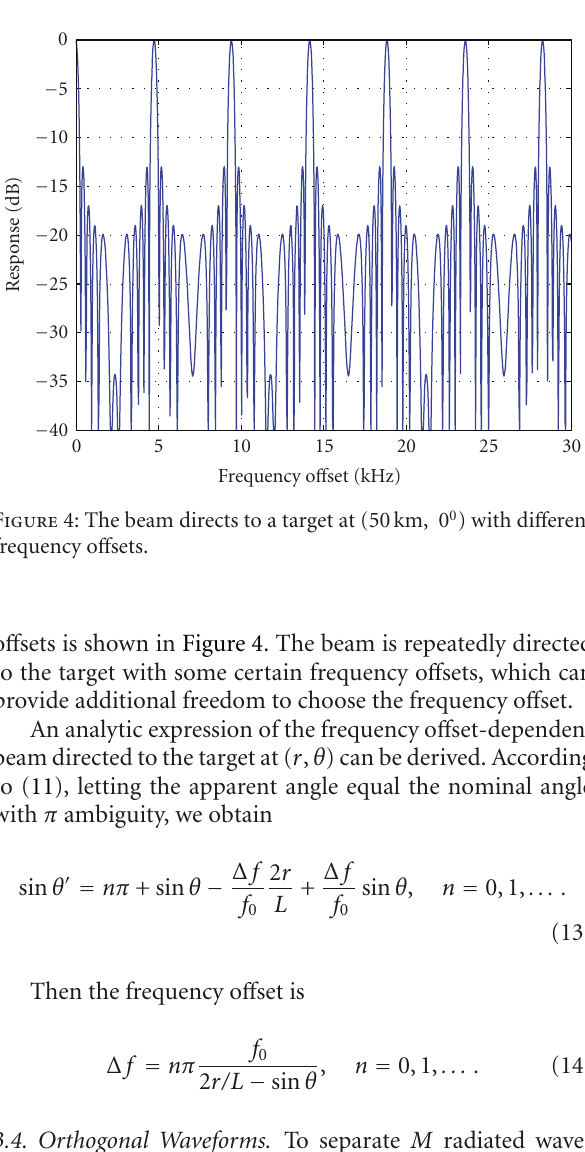
Figure 2: The beam direction varies as a function of range.